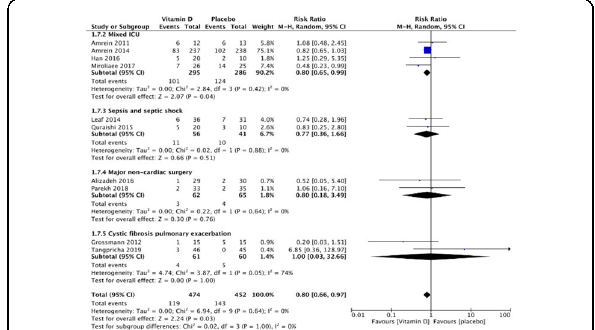
Fig. 1 (abstract 000471). See text for